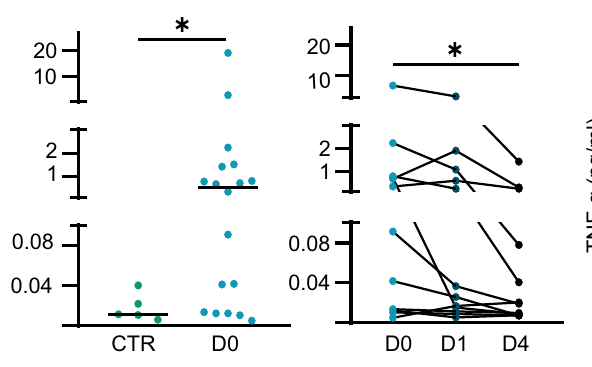
curve,cellsweretreatedwith5,15,50,150and450 ng/ml)for1 hor3 h. The inhibitors of transcription factors, ERK inhibitor PD98059 (20 µ M,